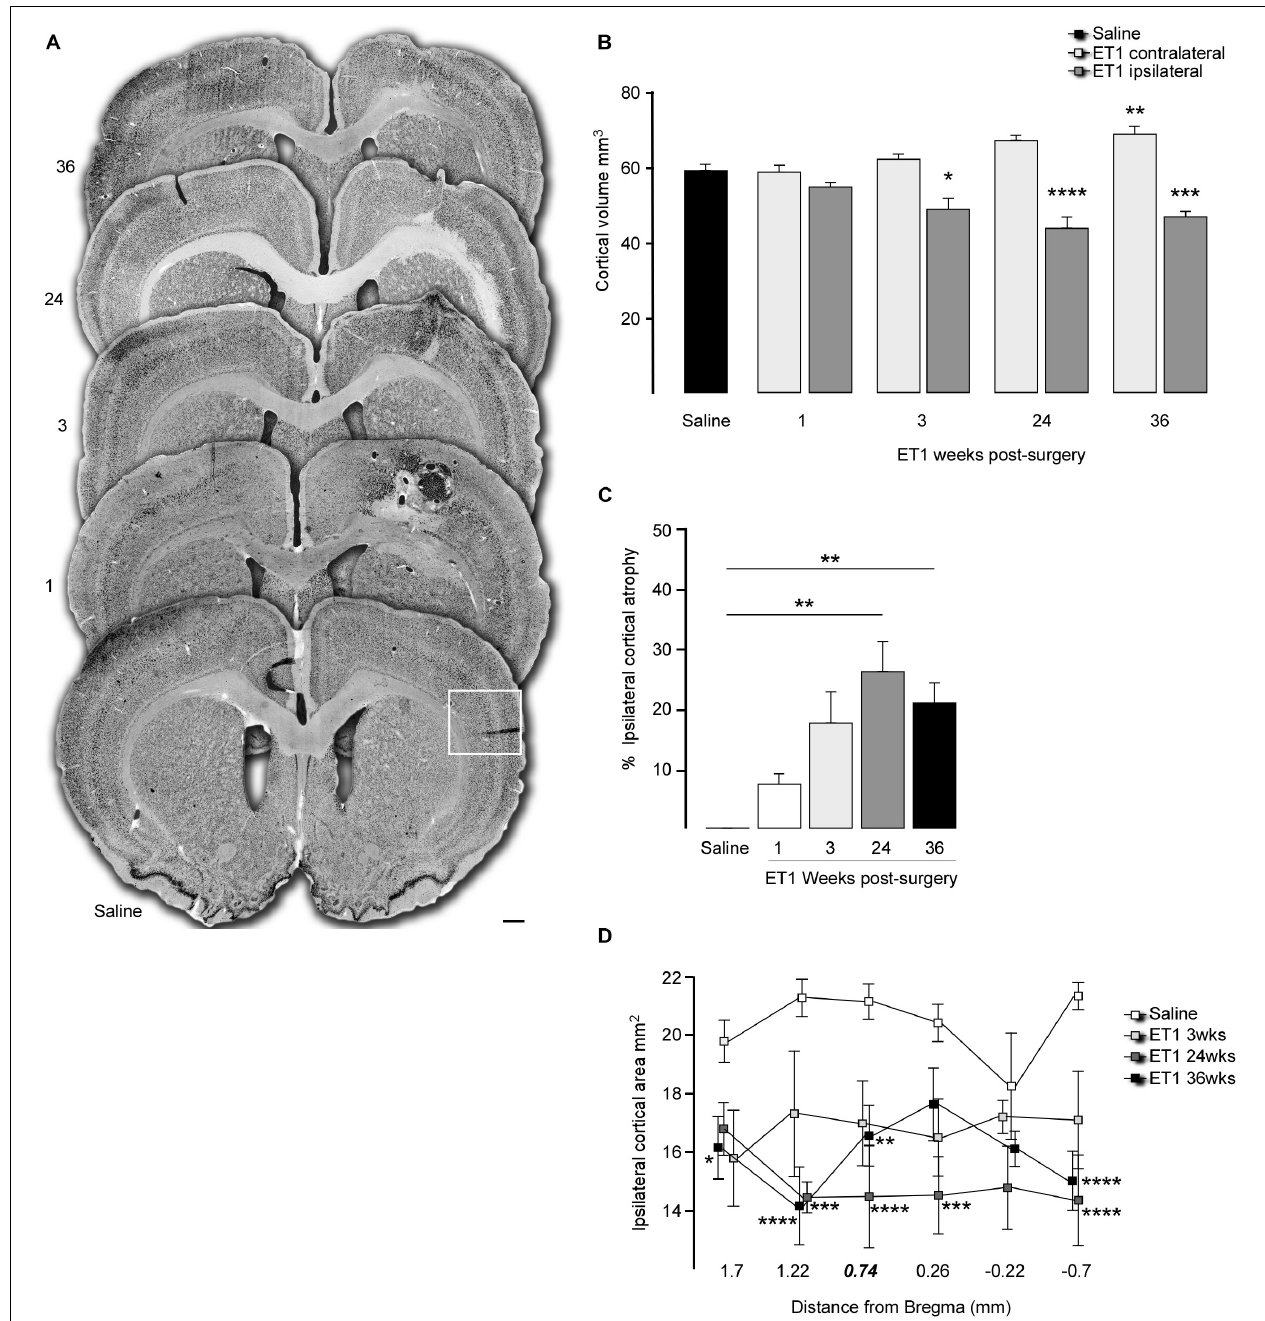
FIGURE 2 | Progressive cortical atrophy after focal ischemia. (A) Representative coronal sections labeled for NeuN illustrate gross morphology for a saline injected animal and 1, 3, 24, and 36 weeks after ET-1 injection (note enlarged versions of the boxed area are illustrated in Figure 3 ). (B) Total hemispheric cortical volume (bregma –2.1 to +2.7) in saline injected animals ( n = 8, pooled data for contralateral and ipsilateral hemispheres shown) and ET-1 animals 1 ( n = 4), 3 ( n = 4), 24 ( n = 5) and 36 ( n = 8) weeks after ET-1 injection, showing a significant loss of volume in the ipsilateral cortex at 24 and 36 weeks (one way ANOVA, F 8 , 41 = 16.87, p < 0.001 with Dunnett’s multiple comparisons tests; ∗ p = 0.0177; ∗∗ p = 0.0046; ∗∗∗ p = 0.0003; ∗∗∗∗ p = 0.0001). (C) Progression of ipsilateral cortical atrophy over time, expressed as% atrophy relative to saline treated animals, shows significant atrophy at 24 and 36 weeks (one-way ANOVA F 4 , 20 = 5.65, p = 0.0033, Dunnet’s multiple comparison test; ∗∗ p < 0.01). (D) Ipsilateral cortical area at specific rostra-caudal levels shows that compared to saline injected animals there was a significant reduction in area initially closest to the ET-1 injection site and then extending to more distal rostro-caudal levels at later time-points [two-way ANOVA with a significance with time F 4 , 144 = 28.83, p < 0.0001; saline ( n = 8), ET-1 3 weeks ( n = 4), ET-1 24 weeks ( n = 5), ET-1 36 weeks ( n = 8); ∗ p < 0.05; ∗∗ p < 0.01; ∗∗∗ p < 0.001; ∗∗∗∗ p < 0.001]. All data shown as the group mean ± SEM. Scale bar: (A) 500 µ m.